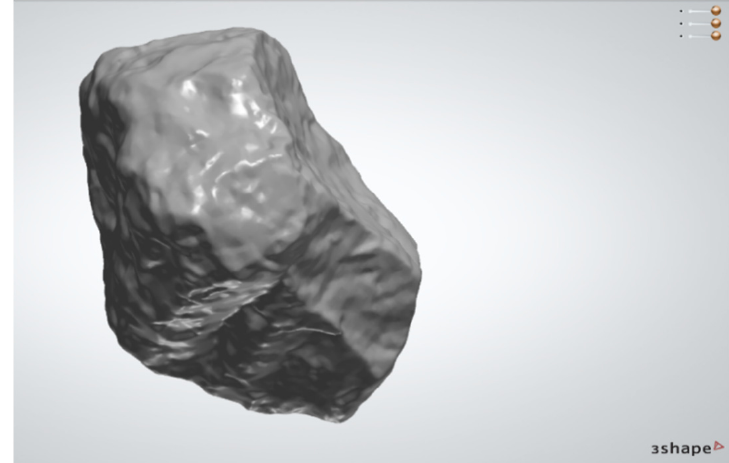
Figure 5. Aggregate scanning.